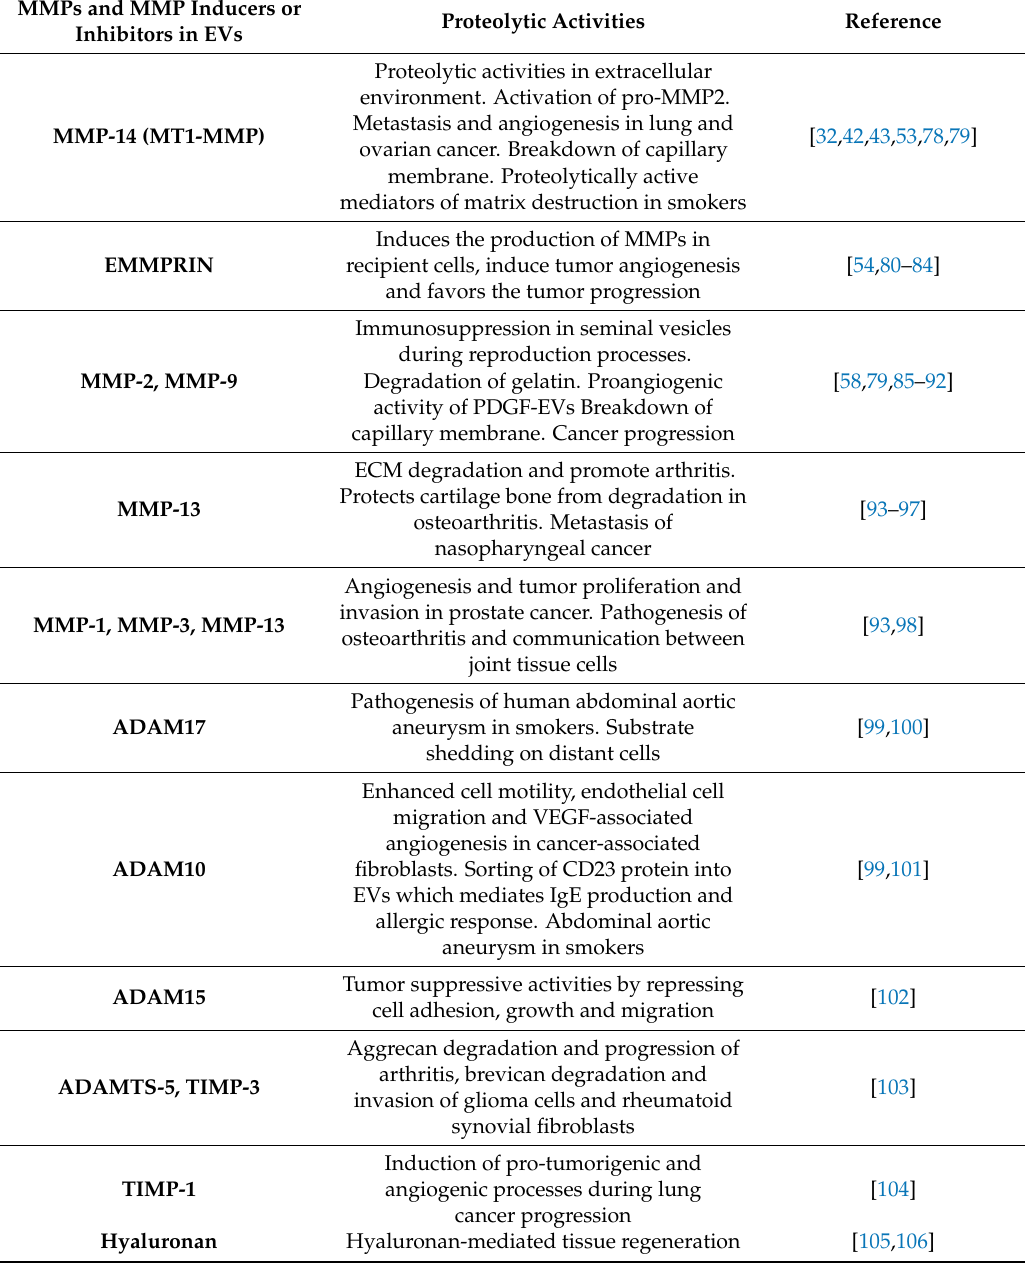
Table 1. List of matrix modulating enzymes and their regulators detected in extracellular